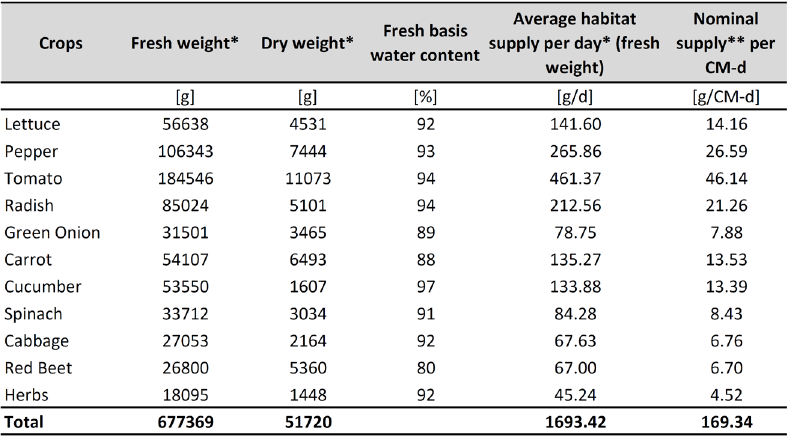
*Over 400 days; ** considered 10 crew